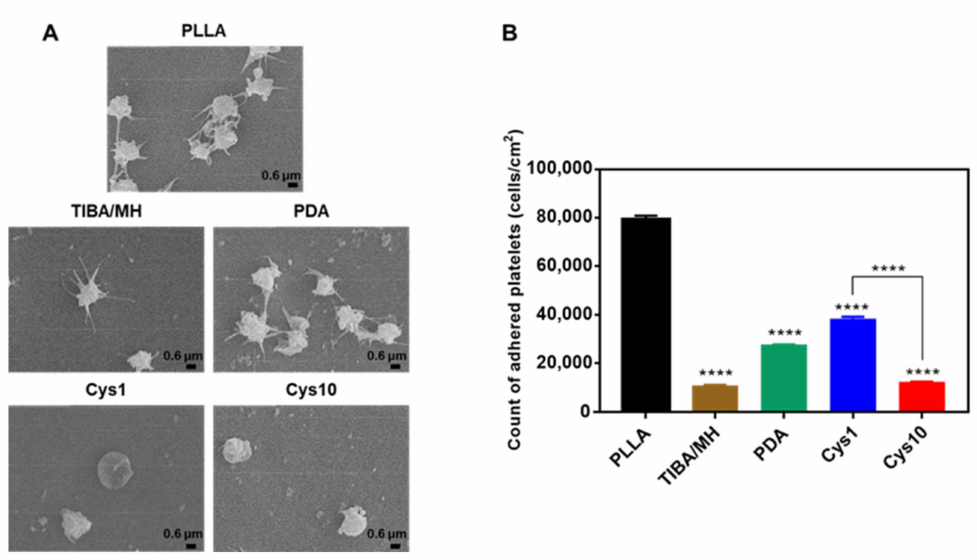
Figure 6. ( A ) SEM images (Scale bar = 1 µ m) and ( B ) LDH assay of adhered platelets on the surface of the coated films (**** p < 0.0001 vs.